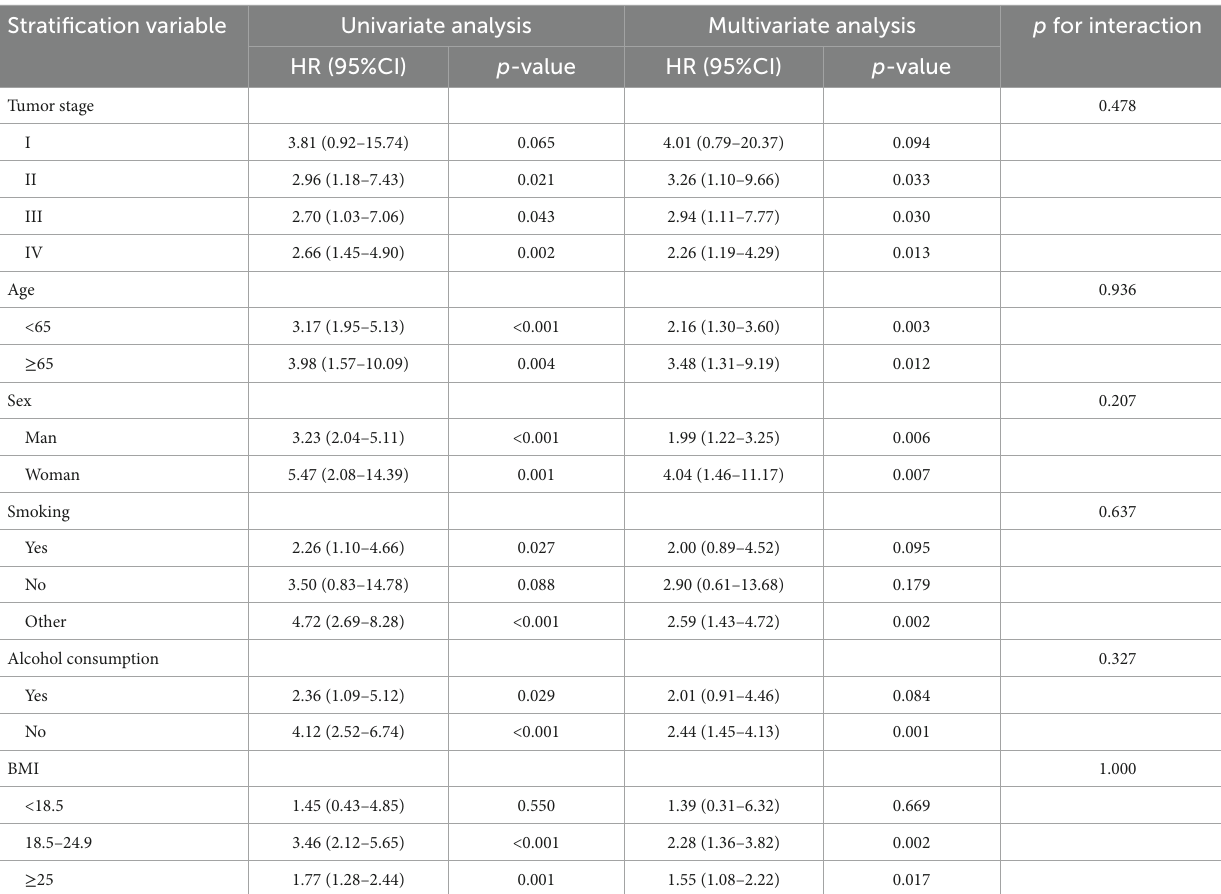
TABLE 3 HGS, mGPS, and liver cancer overall survival stratified by body mass index, tumor stage, age, sex, smoking, and alcohol consumption. Stratification